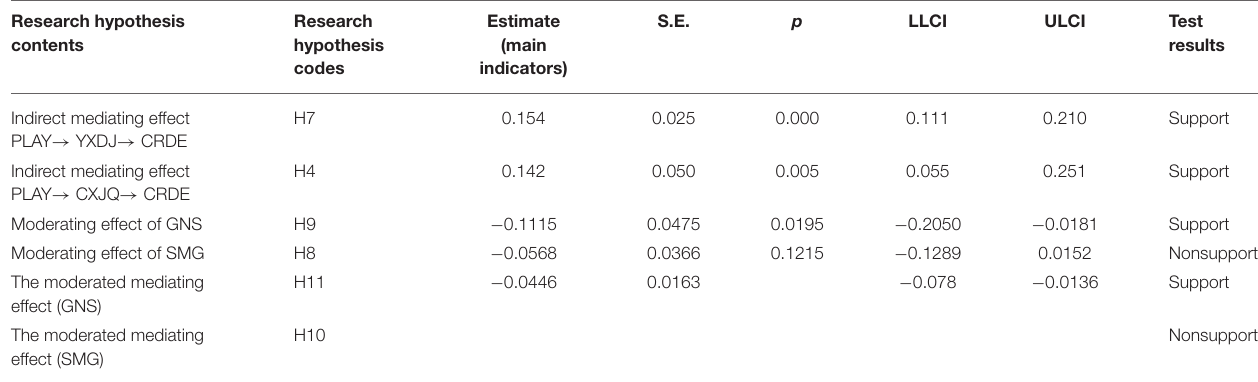
TABLE 18 | Research hypothesis test results summary